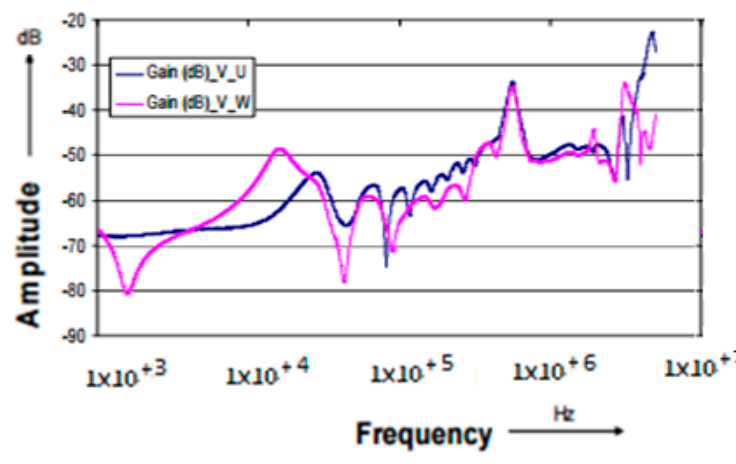
Figure 10. FRA measurement between HV ‐ LV windings for a normal healthy transformer [21].